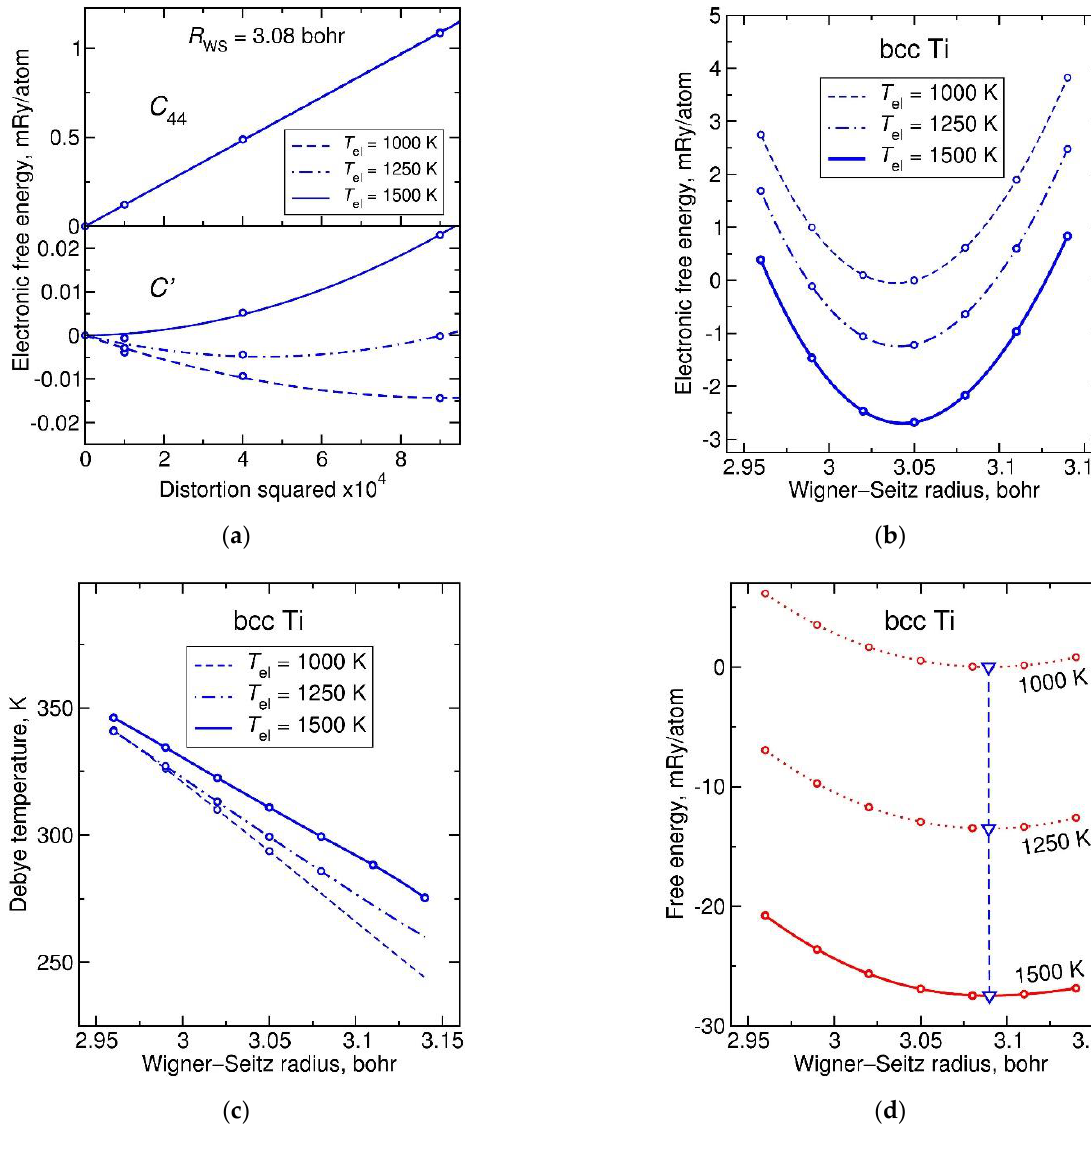
Figure 4. Parameterization of the Debye model using elastic constant calculations for mechanically unstable bcc Ti, a metal with an open d -electron shell: ( a ) electronic free energy dependencies on two shear distortions, to calculate 𝐶 44 and 𝐶′ at each considered 𝑅 WS and 𝑇 el ; ( b ) electronic free energy dependence upon isotropic strain, to calculate adiabatic bulk modulus 𝐵 el (𝑉 , 𝑇 el ) ; ( c ) Debye temperature estimated from 𝐶 44 , 𝐶′ , and 𝐵 el . Open circles indicate (𝑅 WS , 𝑇 el ) points where the three elastic moduli are positive, missing points mean elastic instability of bcc lattice; ( d ) Helmholtz free energy obtained by adding the vibrational free energy in the Debye model to the electronic free energy. Dotted lines indicate temperatures at which Θ D is partly imaginary. Dashed line with down triangles indicates the temperature-dependent equilibrium volume.